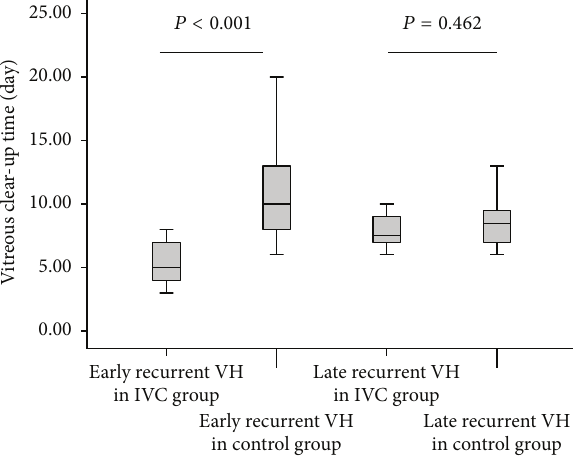
Figure 3: Graph showing vitreous clear-up time of early and late recurrent vitreous hemorrhage in participants with or without conbercept pretreatment. Subgroup pairwise analysis showed sig- nificant differences between IVC group and control group in early recurrentVHclear-uptime( 𝑃 < 0.001 ),butnostatisticaldifferences in late recurrent VH clear-up time between the two groups ( 𝑃 > 0.05 ). VH: vitreous hemorrhage; IVC: intravitreal